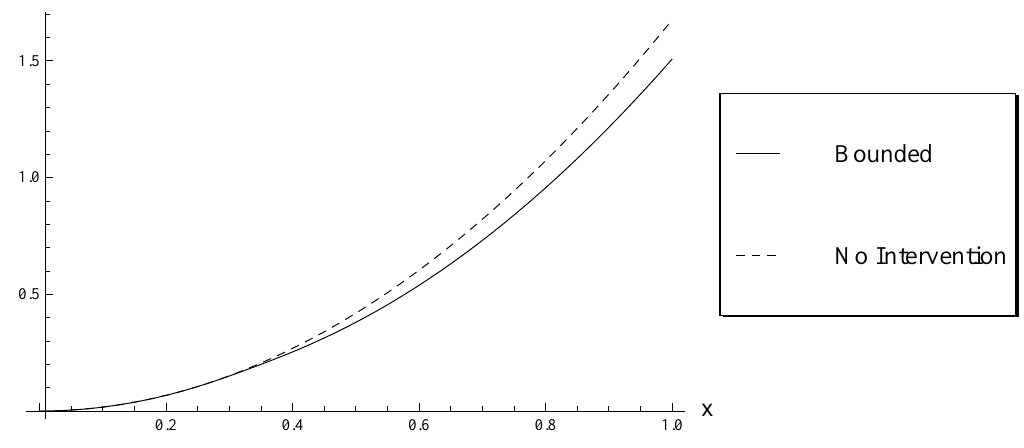
Figure 2. The value function (for the bounded-intervention model) versus the total cost of the non-intervention